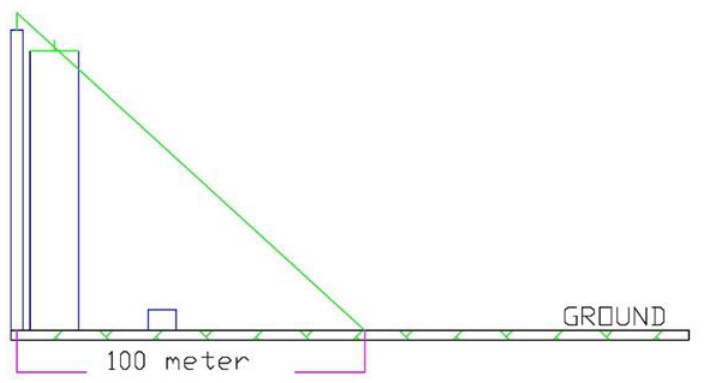
Figure 7. Maximum lightning protection zone at ∝ =47.7°.